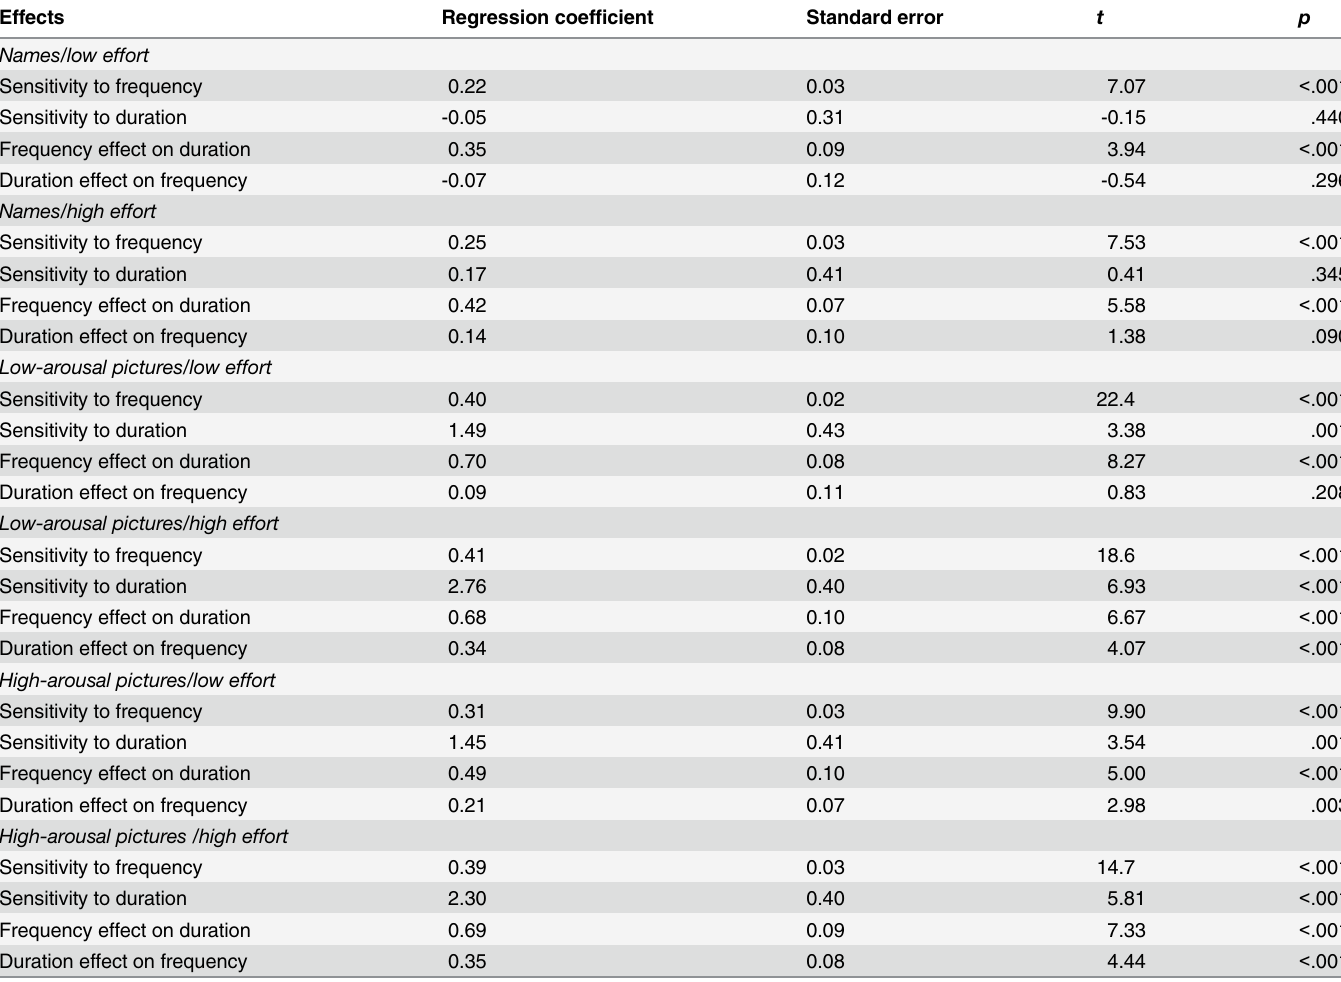
Table 2. Coefficients from the two-level regression model predicting the main effects of frequency and duration for names, low- and high-arousal pictures processed under low and high